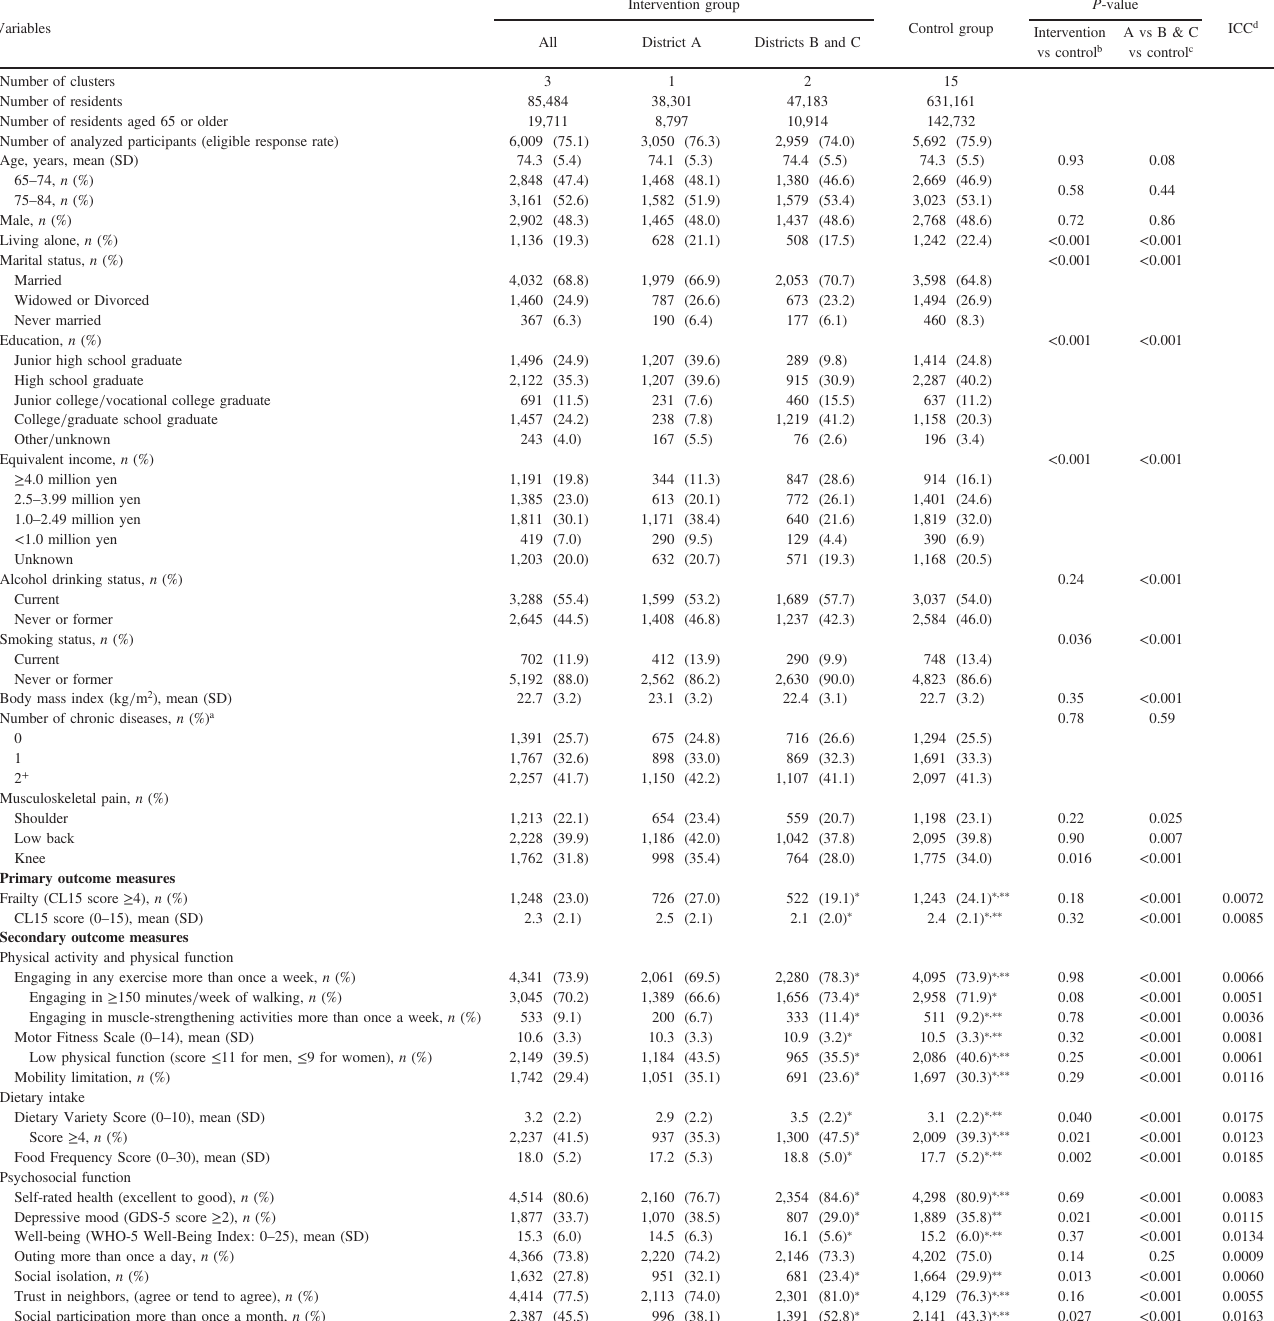
Intervention group All District A Districts B and C